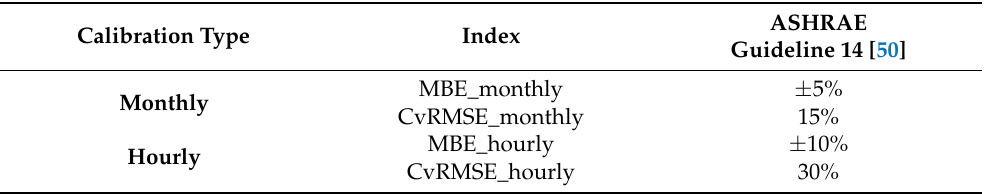
Table 2. Acceptable Calibration Tolerances in building energy performance